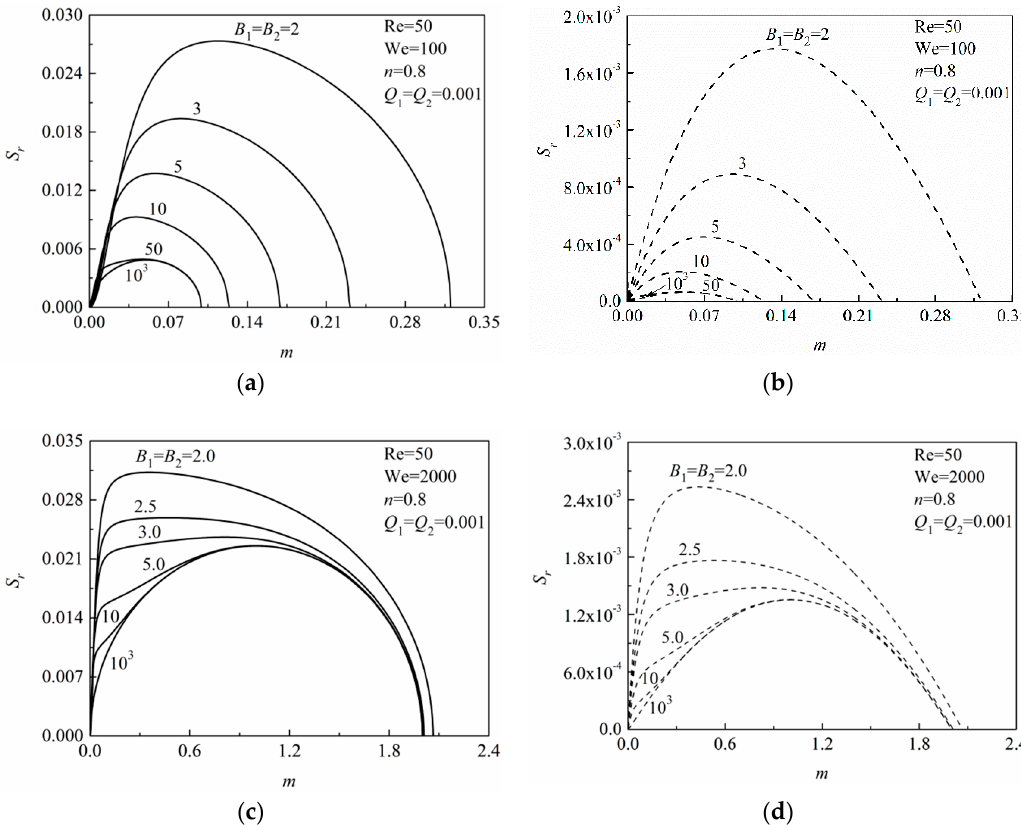
Figure 3. The dimensionless growth rate S r of disturbance waves as a function of the non-dimensional wave number m for low ( a , b ) and high speed ( c , d ) jet. The solid ( a , c ) and dashed lines ( b , d ) represent para-sinuous mode and para-varicose mode